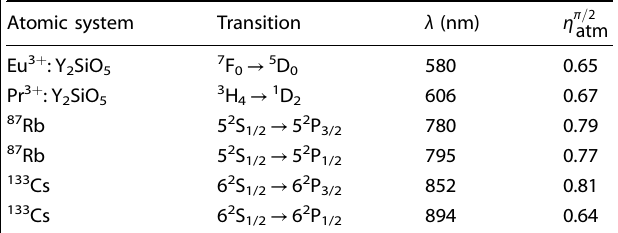
Table 2. Wavelengths ( λ ) and η π = 2 atm for several quantum memory